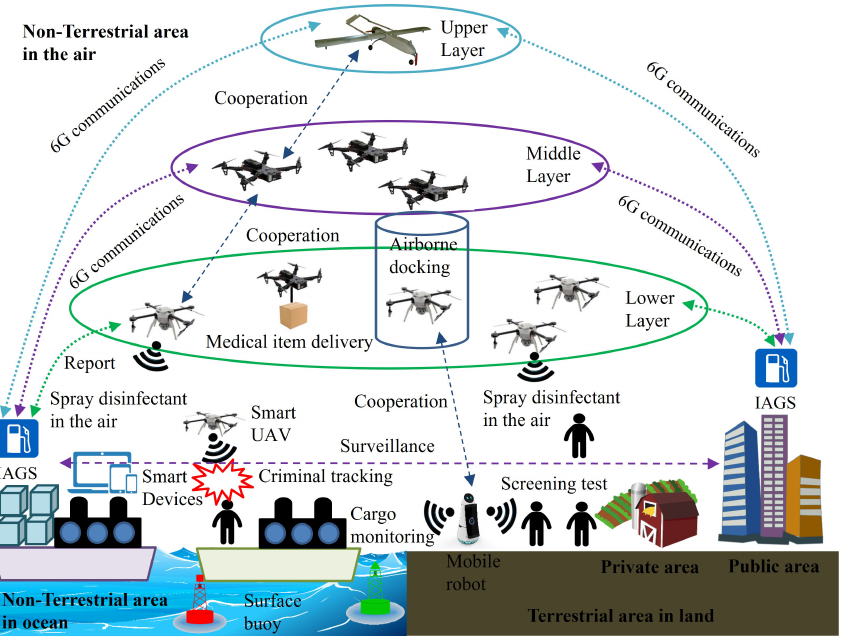
Figure 2. An example of system components and their activities in 6G-supported terrestrial and non-terrestrial areas.